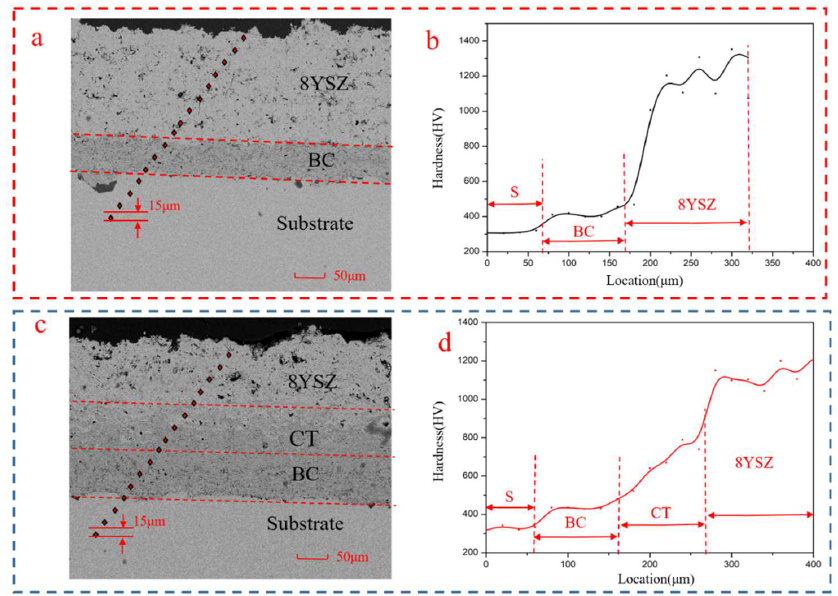
Figure 4. SEM image of traditional coating ( a ) and continuous transition coating ( c ), Vickers hard- ness of traditional coating ( b ) and continuous transition coating ( d ). of traditional coating ( b ) and continuous transition coating ( d